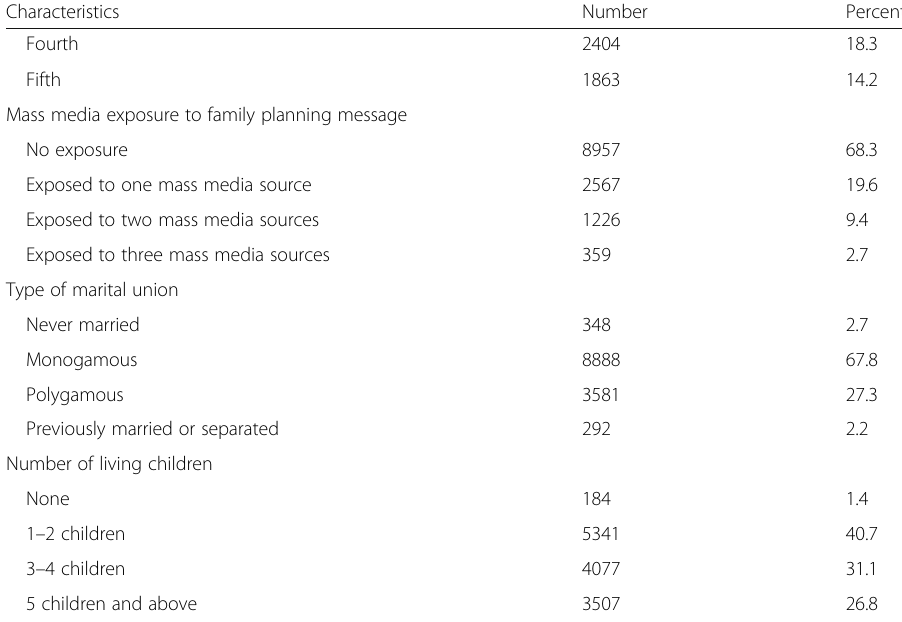
Table 1 Background characteristics of study participants (NDHS 2018), N = 13,109 (Continued)